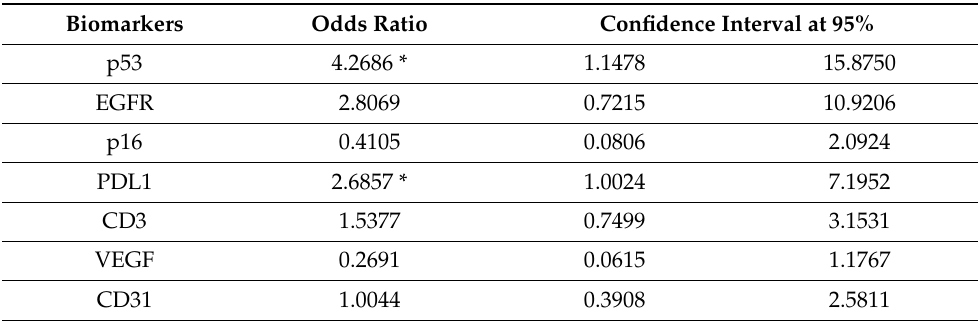
Table 3. Generalized linear model for biomarkers. Odds for lymph node metastasis in the mutant (exposed) over the non-mutant (not